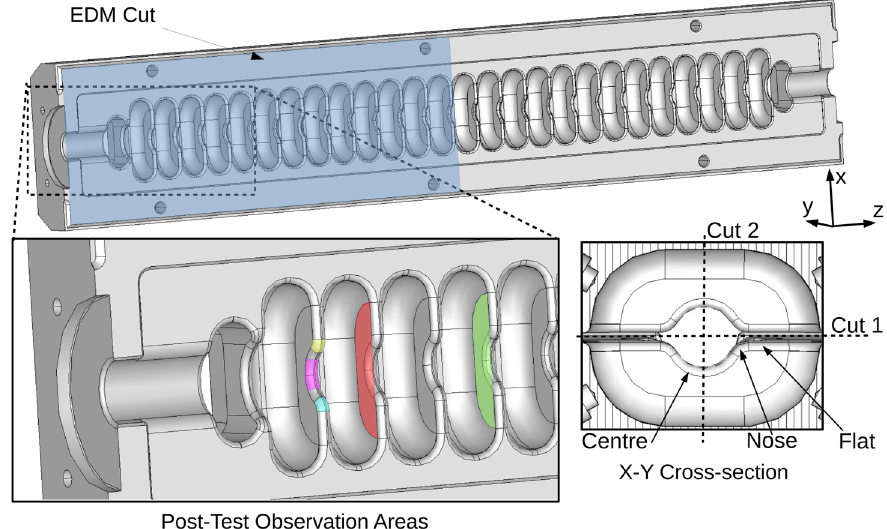
FIG. 14. Diagram of a half of the CLIC-G-OPEN structure demonstrating the EDM cut in blue. Post-test observations with a borescope looked at the iris 2 (red) and iris 4 (green) before cutting. After cutting, SEM images of the first iris looked at the left (yellow) and right (cyan) nose, and the center (magenta). An X-Y cross section demonstrating structure